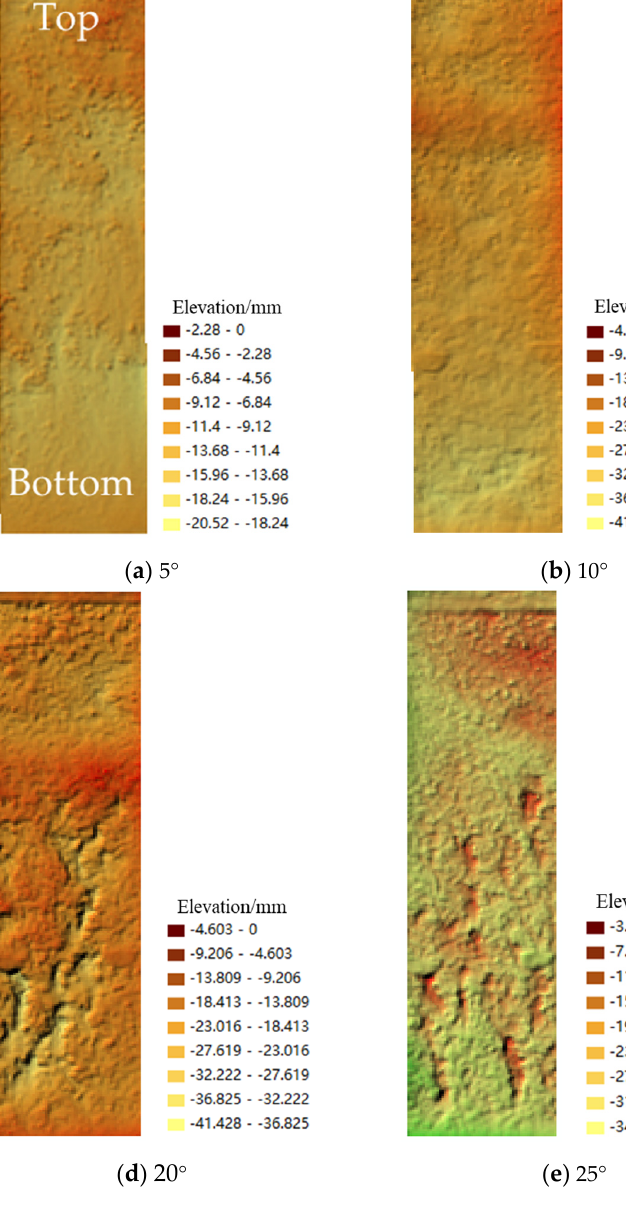
Figure 5. Morphological characteristics of slope erosion under different slope gradients.